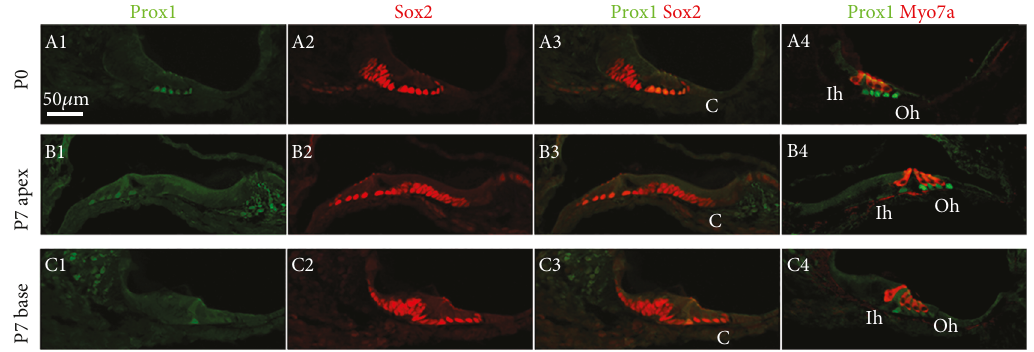
Figure 7: Prox1 is expressed in the neonatal mouse cochleae. Immunohistochemistry of Prox1, Sox2, and anti-myosin7a from P0 to P7. Scale bars =50 μ